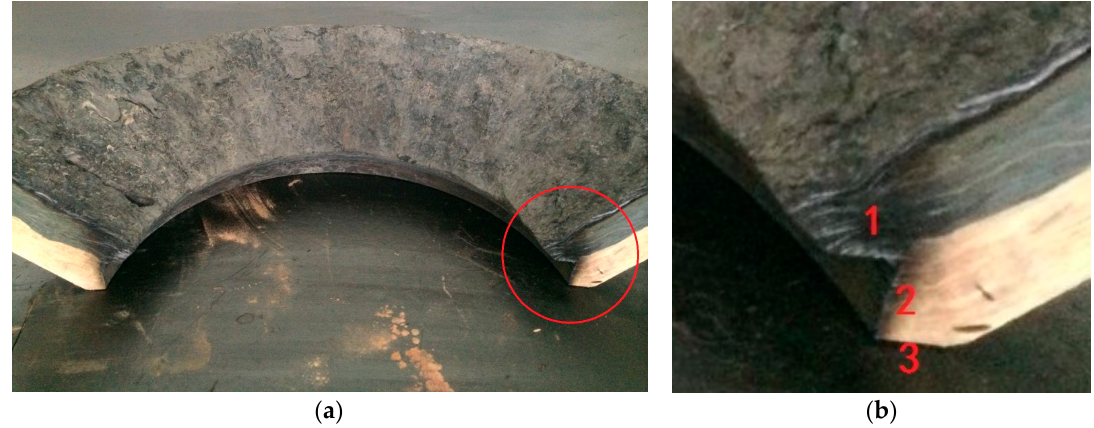
Figure 15. Convergent region after experiment. ( a ) Overview of the convergent region; ( b ) Highlighted region of ( a ).